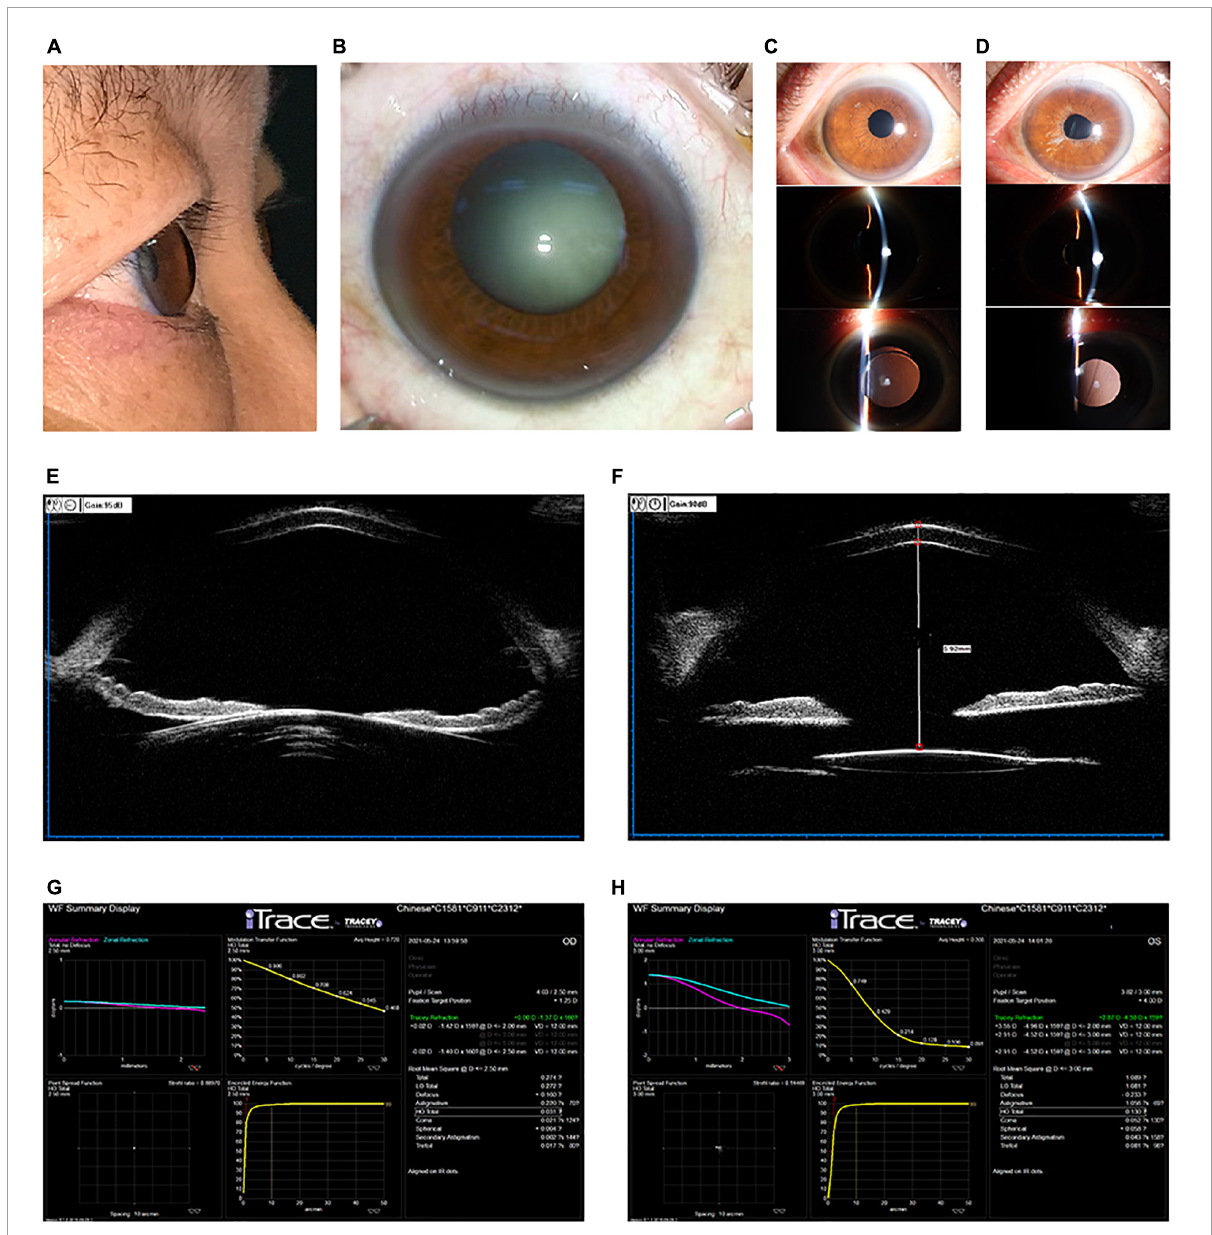
FIGURE2 (A,B) Color photography of the right eye before surgery showed cataract and a significantly deepened anterior chamber. (C) Photographs of the right eyes by slit-lamp microscopy at 1 year after surgery at our hospital. The IOL was stably positioned in the eye. (D) Photographs of the left eyes by slit-lamp microscopy at 1 year after the right eye surgery at our hospital. The left iris pigment was dispersed. (E,F) Ultrasound biomicrographs of the right eye before (E) and after (F) surgery at our hospital. Panel (E) showed a deep anterior chamber and elongated zonular fibers. The panel (F) revealed the IOL to be centrally located in the eye after surgery. (G,H) Aberrometry using the iTrace system, showing visual quality in the right eye (G) and left eye (H) after right eye surgery at our